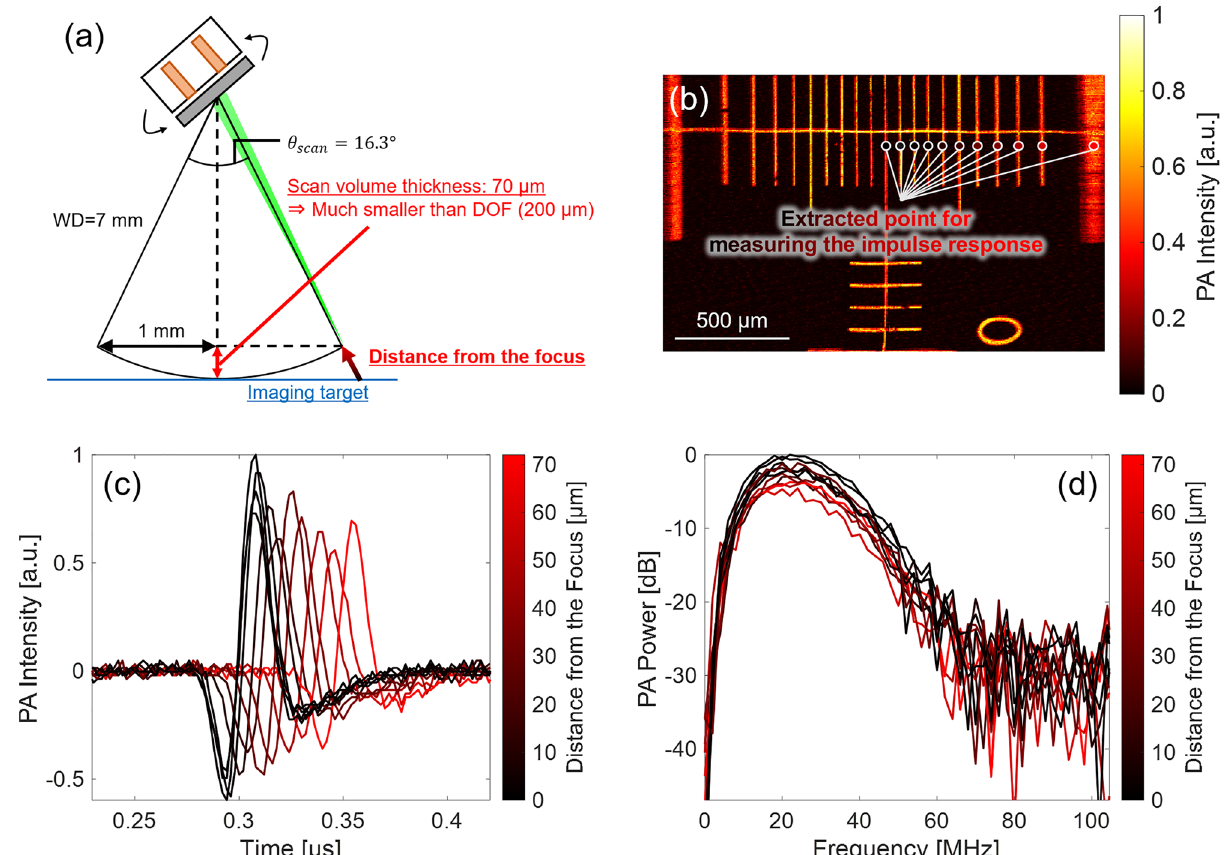
Figure 9. Investigation of the spatial variation of signal detection sensitivity derived by MEMS scanning. ( a ) MEMS scan geometry in X = 2 mm, which represents the variation of the focal position in the thickness direction (Max: 0.07 mm) was within the experimental DOF (0.20 mm). ( b ) C-mode image (w/o distortion correction) of the ruler indicating the extracted position for measuring the signal impulse response. ( c ) Time waveforms of the impulse responses. ( d ) Frequency waveforms of the impulse